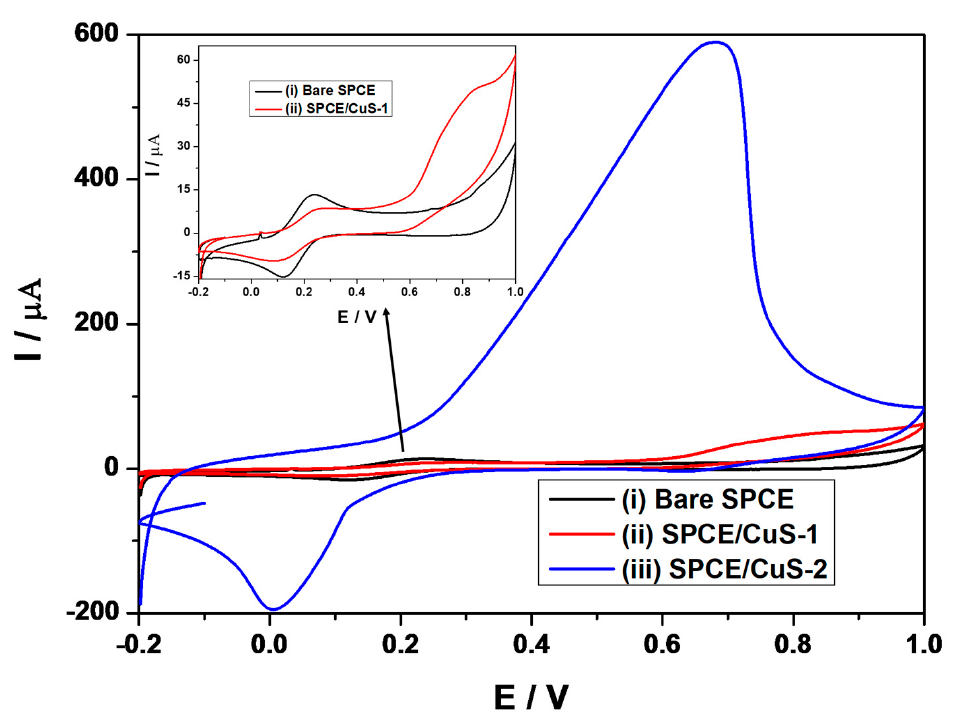
Figure 4. Cyclic voltammetry plots of (i) bare and (ii) CuS-1-, and (iii) CuS-2-modified SPCE in 1 mM K 3 [Fe(CN) 6 ]/K4[Fe(CN) 6 ] redox probe containing 1 M of KCl, at a potential window between − 0.2 and 1 V, at a fixed scan rate of 0.05 Vs − 1 . Insert: cyclic voltammogram highlighting the SPCE/CuS-1 and the bare SPCE.